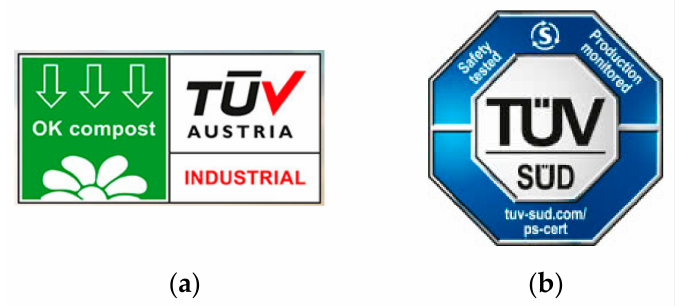
Figure 2. The “OK compost” certification mark issued by TÜV AUSTRIA ( a ); the TÜV SÜD Italy octagon conformity mark, globally known and recognized, enabled by TÜV SÜD Product Service ( b